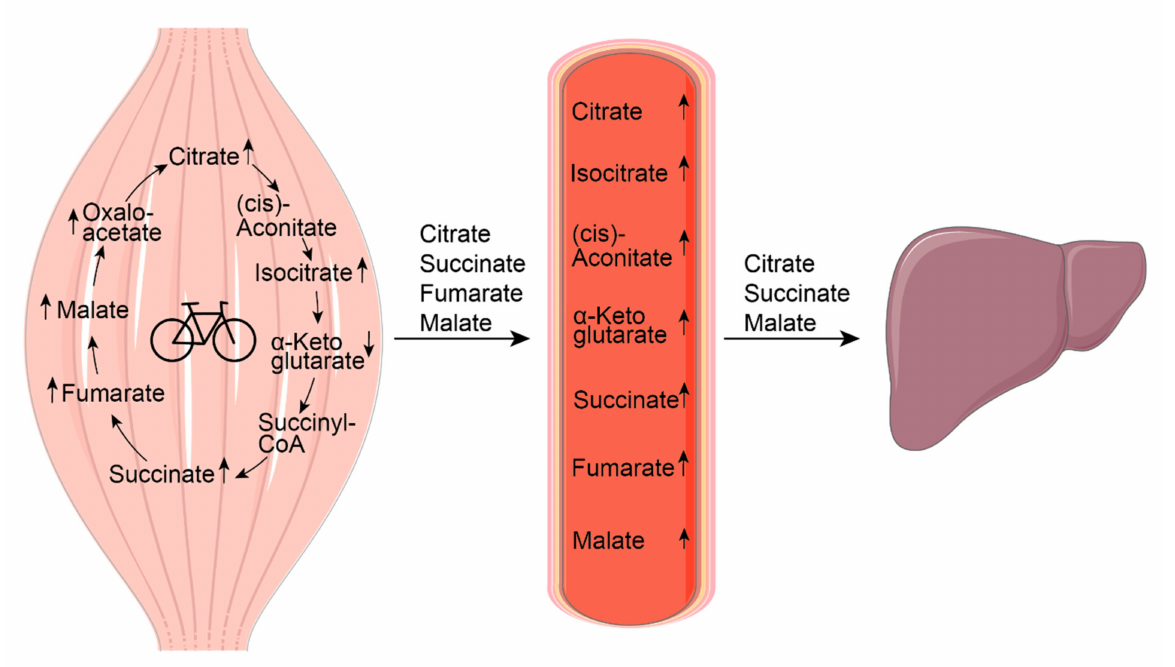
Figure 2. Exercise-induced changes in TCA intermediate concentrations and fluxes. Intramuscular and plasma concen- trations of most TCA intermediates increase above resting levels in the contracting skeletal muscle [23,27]. There is evidence of an increased muscular release of citrate [35,36], succinate [37,38], fumarate [38] and malate [38,39], as shown by analyses of arterio-venous differences. Citrate, succinate and malate are taken up into the hepato-splanchnic region, suggesting an uptake by the liver [36,39]. The figure was created using Servier Medical Art templates, which are licensed under a Creative Commons Attribution 3.0 Unported License; https://smart.servier.com (accessed on 22 June